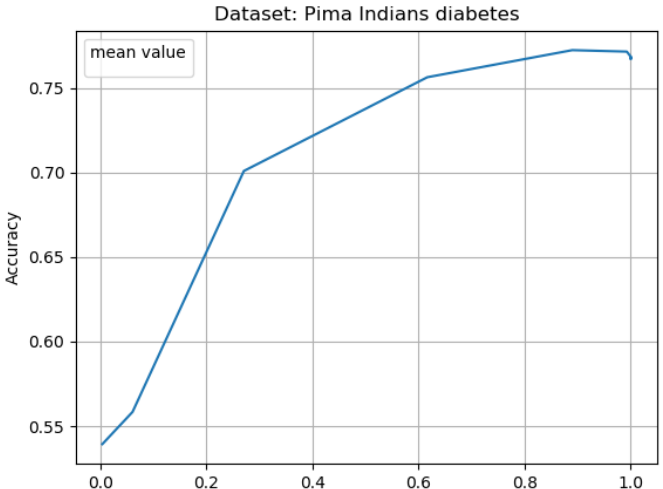
Figure 8. Mean results for 10 learning cycles, using 10 splits; for Pima Indians Diabetes data set; Mean result for 10 learning cycles, using 10 splits; for Australian credit data set; The only way to show the average values from the experiments was to calculate the average accuracy for specific granulation radii. Hence, on the x-axis we have the granulation radii (approximation levels). The figure shows the result from Table